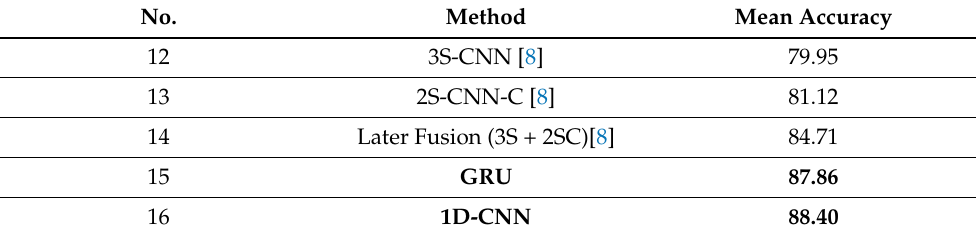
Table 9. Comparison with state-of-the-art SLR methods on the LIBRAS-BSL dataset. No.